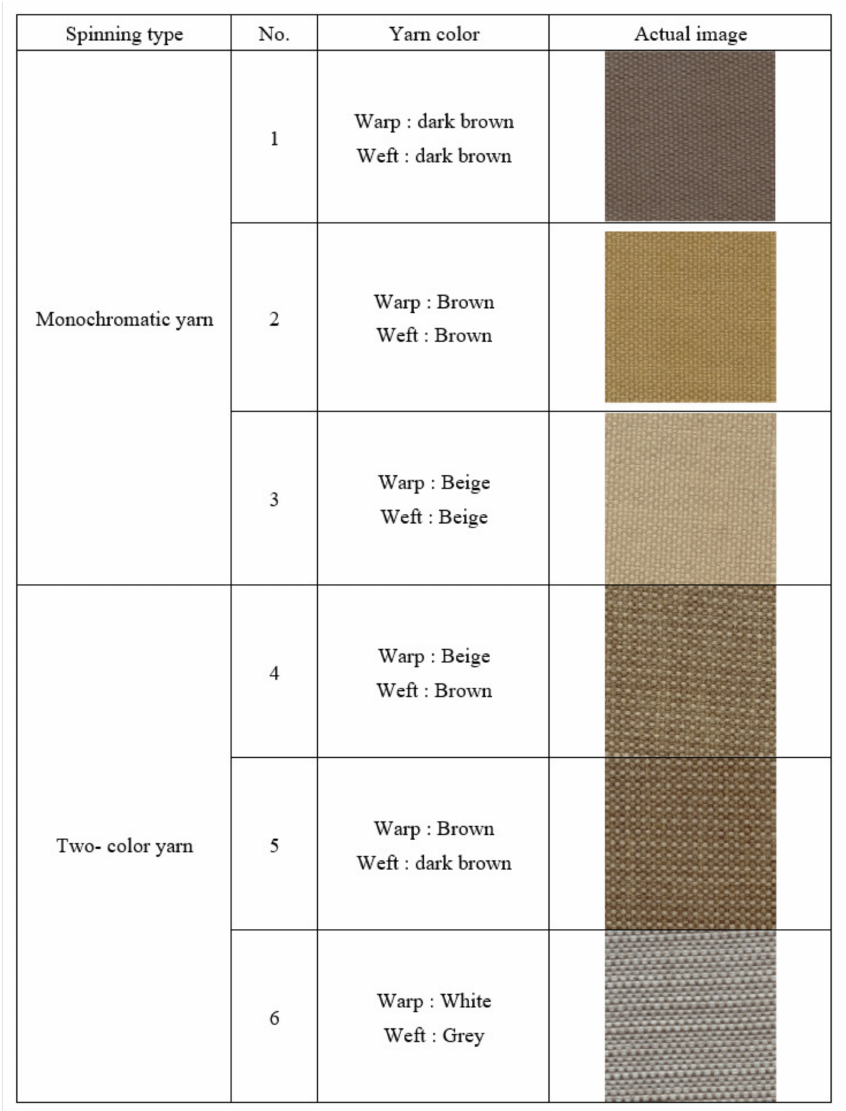
Figure 2. Detection of cloth